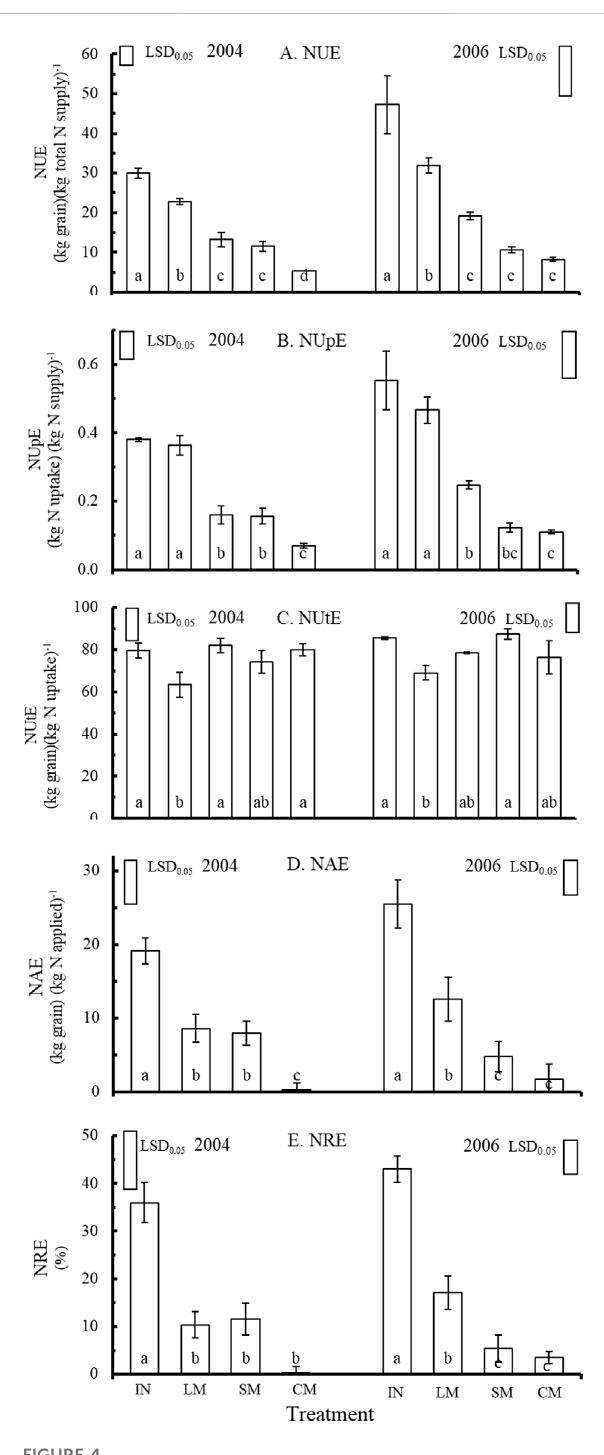
FIGURE 4 Changes in the selected N use ef fi ciency parameters for corn as affected by nutrient sources. (A) NUE, N use ef fi ciency; (B) NUpE, N uptake ef fi ciency; (C) NUtE, N utilization ef fi ciency; (D) NAE, N